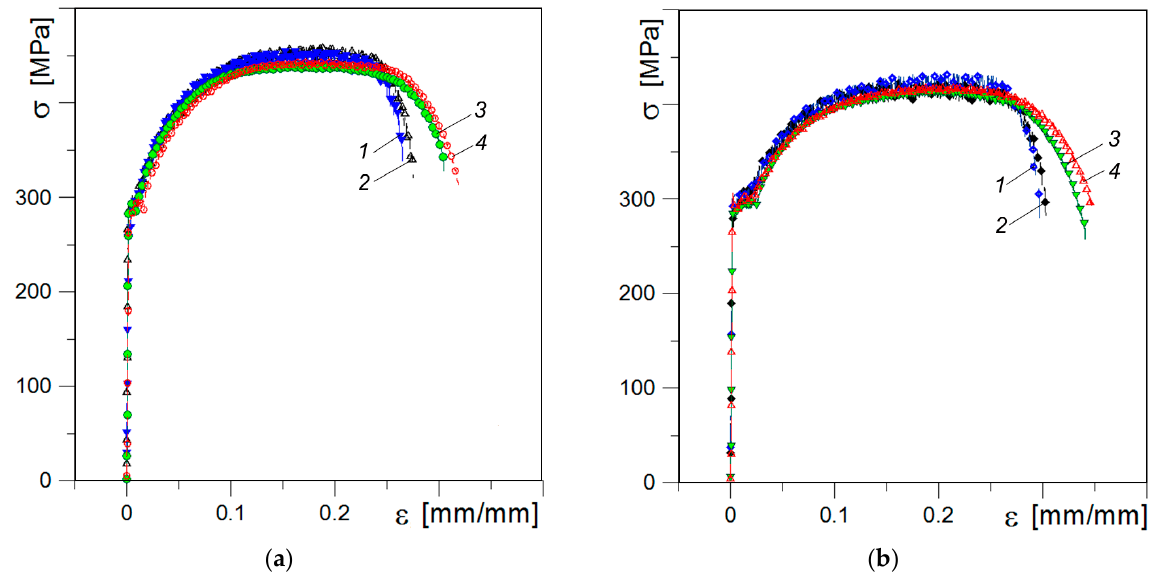
Figure 6. Stress–strain curves of steel A ( a ) and B ( b ) for thinner ( 1 , 2 ) and thicker ( 3 , 4 ) specimens of transverse ( 1 , 3 ) and longitudinal ( 2 , 4 ) orientation. Table 4. Mechanical properties of the tested specimens evaluated by tensile testing.